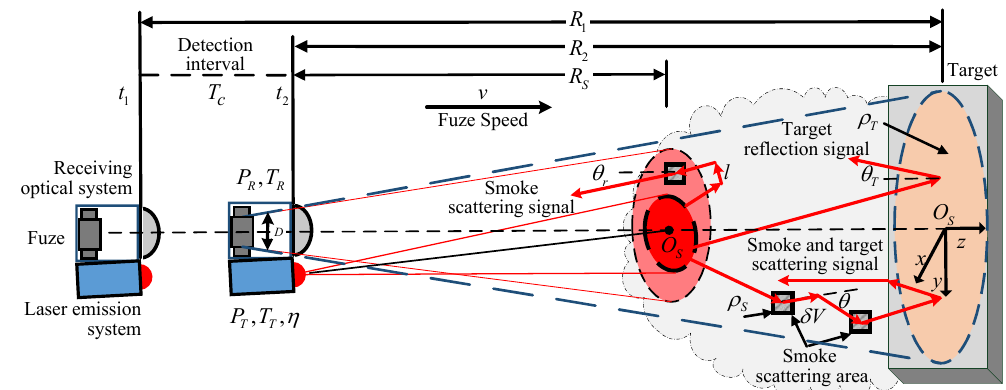
Figure 2. Multiple scattering model and detection process, simulating the movement of fuze with speed of v and a time interval of T c between two